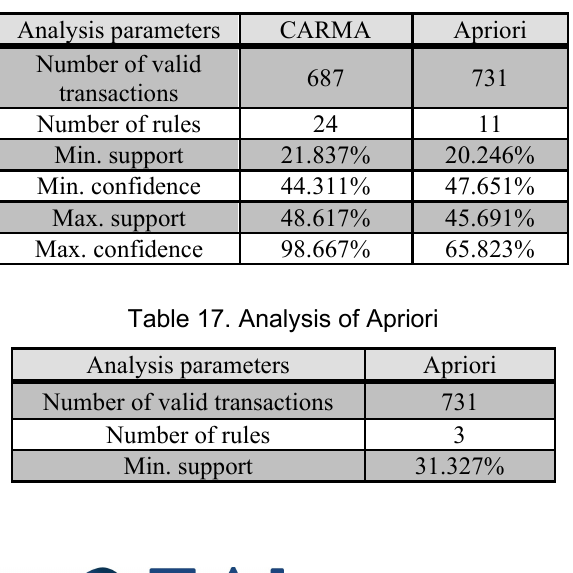
Table 16. Difference CARMA and Apriori